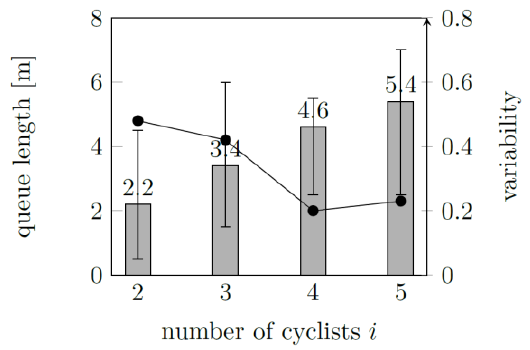
Figure 8. Queue length vs. queue size (number of cyclists). Bars denote mean length; limits denote min and max values; line denotes the variability Table 5. Queue